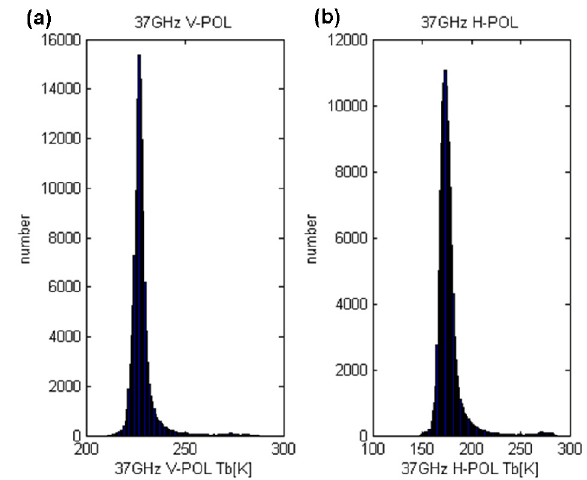
Figure 6. Histogram of the TB for the TMI in the absence of rain at 21 GHz.